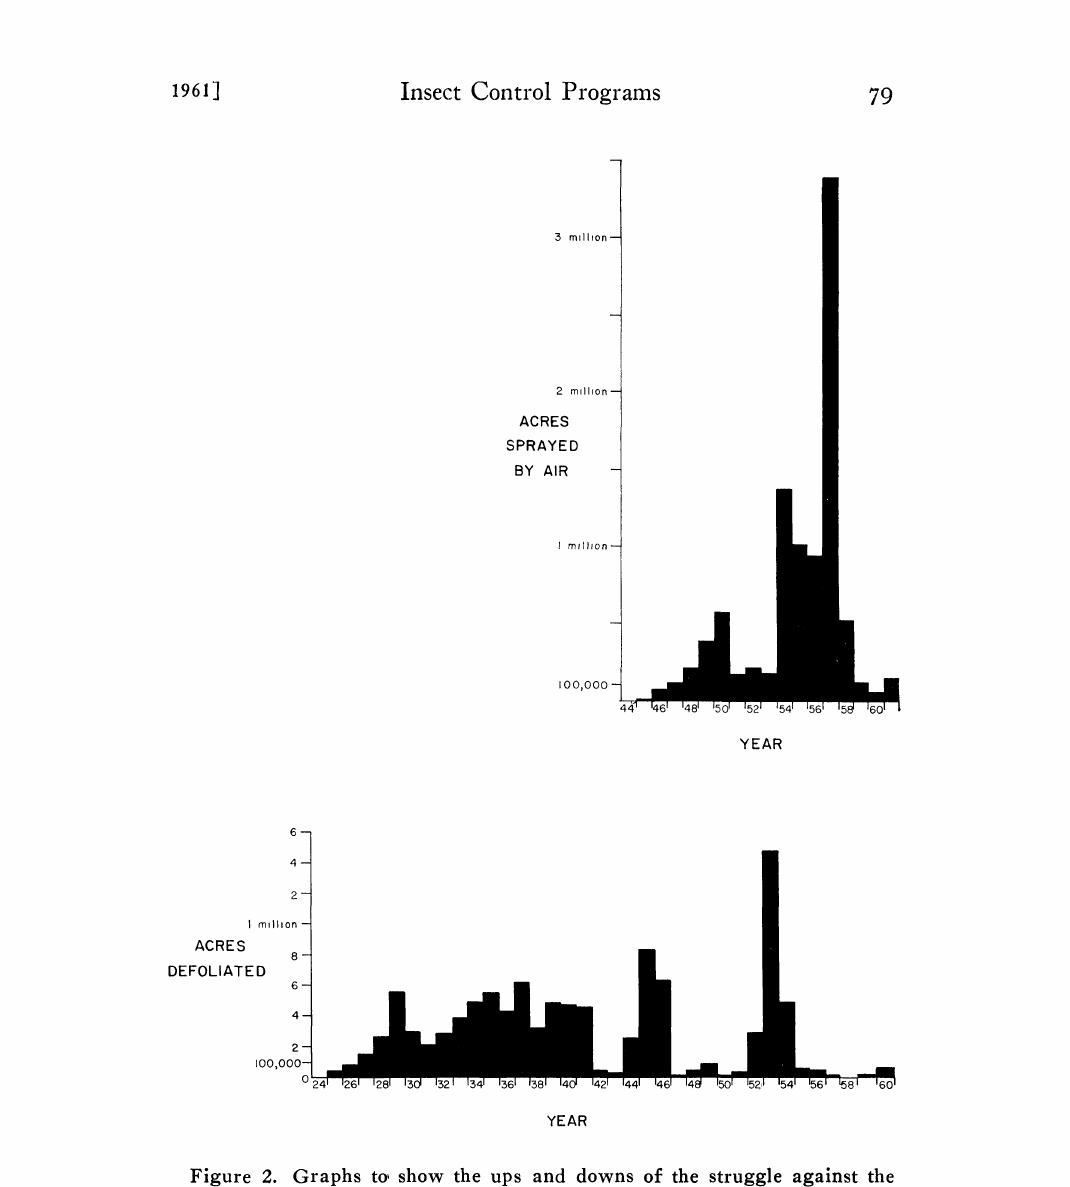
Figure 2. Graphs to, show the ups and downs of the struggle against the gypsy moth in the U.S. Acreage showing substantial defoliation by gypsy moth larvae each year (below) is compared with acreage sprayed from the air (above) mostly with DDT at lb per acre. Some suppression treatments used only 1/2 or 3/4 lb of DDT per acre, and sevin has partly replaced DDT in recent years. For details, see summaries by USDA in Appendix A, upon which these graphs are